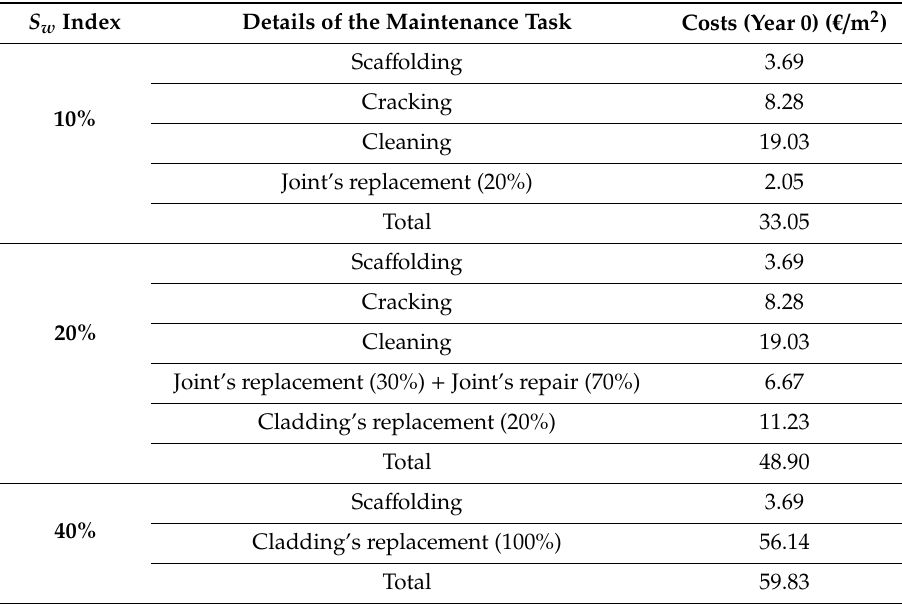
Table 6. Fixed costs of the maintenance actions (data sourced from CYPE [19] and Mousavi et al. [13]). S w